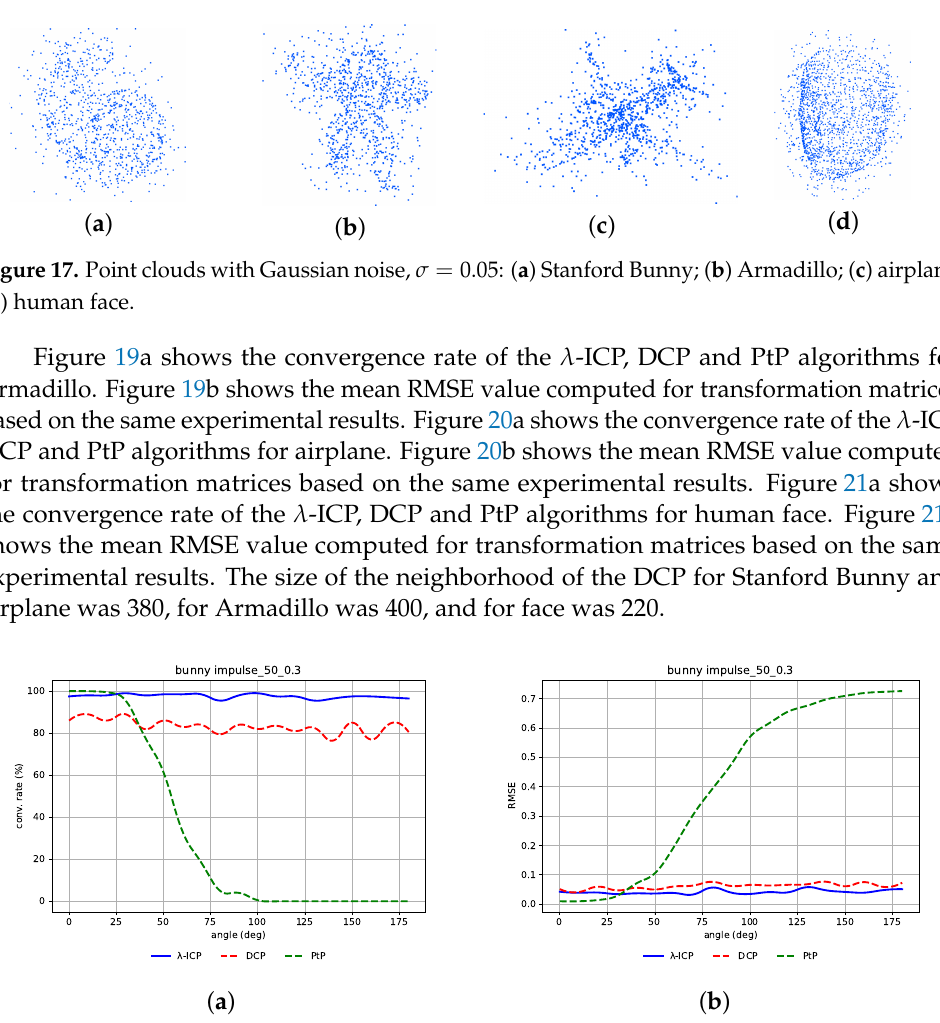
Figure 18. ( a ) Convergence rate of λ -ICP (blue), DCP (red), PtP (green) algorithms for Stanford Bunny with impulse noise; ( b ) mean RMSE (for transformation matrices) of λ -ICP (blue), DCP (red), PtP (green) algorithms for Stanford Bunny with impulse noise.